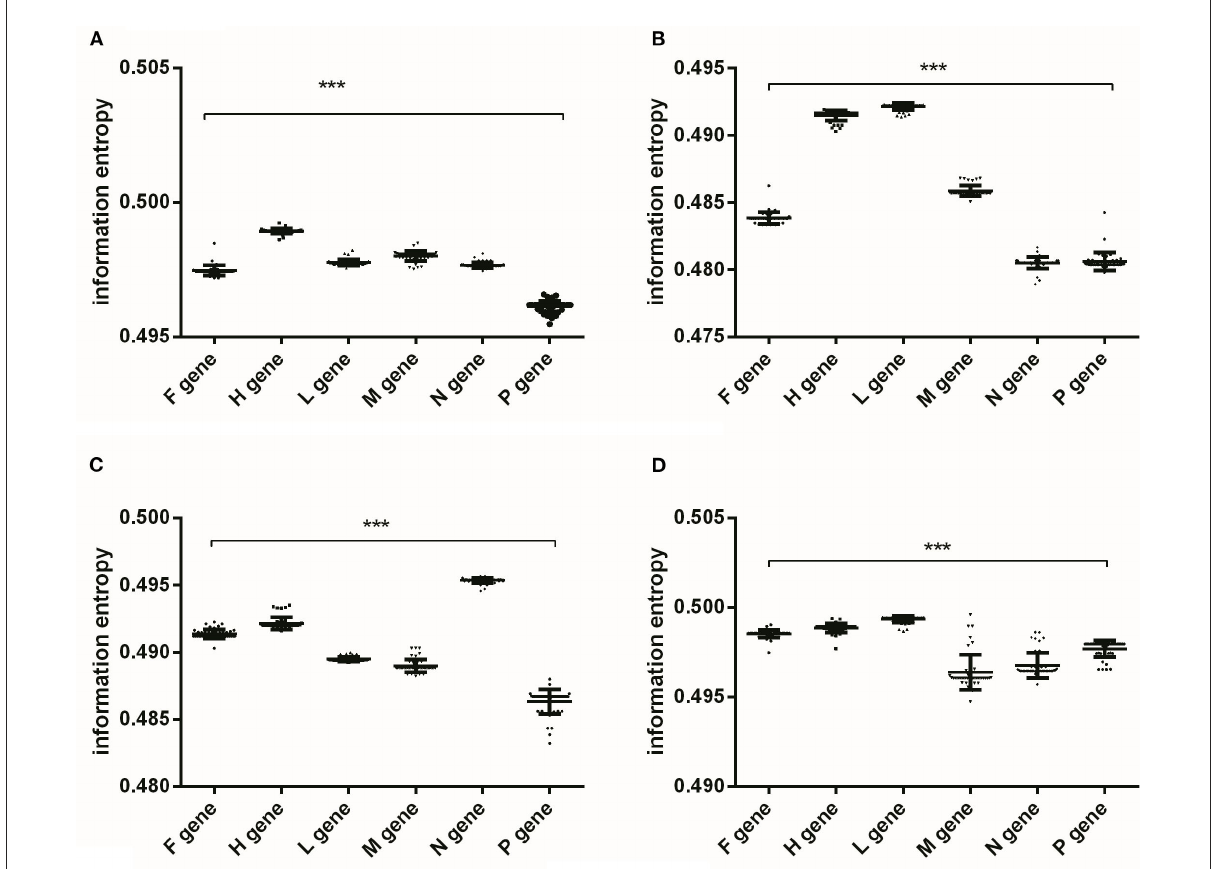
FIGURE2 The analysis of nucleotide usage bias of PPRV coding sequences performed by information entropy. (A) the overall nucleotide usage bias at gene levels, and significant differences of the overall nucleotide usage biases among the six coding sequences; (B) the nucleotide usage bias at the first codon position, and significant differences of nucleotide usage bias at the first codon position among the six genes; (C) the nucleotide usage bias at the second codon position, and significant differences of nucleotide usage bias at the second codon position among the six genes; (D) the nucleotide usage bias at the third codon position, and significant differences of nucleotide usage bias at the third codon position among the six genes. The One-way ANOVA method is used for estimating the differences of nucleotide usage biases among the six genes, and p -value < 0.001 remarks as